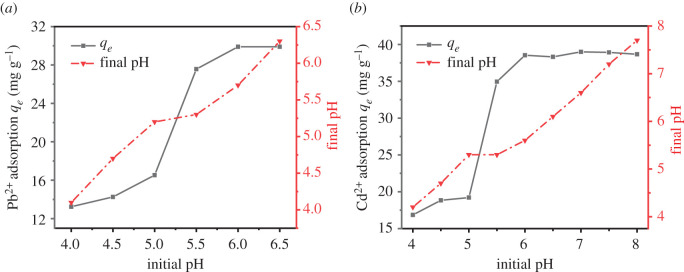
The effect of pH on adsorption of Pb2+ (a) and Cd2+ (b).